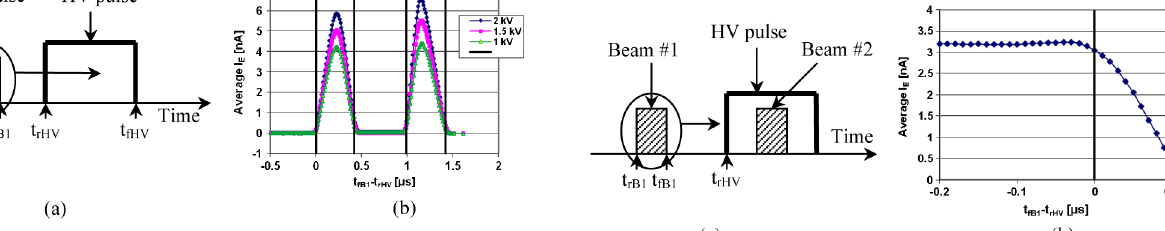
FIG. 6. (a) Pulsing diagram of the test, T B1 ¼ T B2 ¼ 0 : 1 (cid:1) s , ¼ 1 (cid:1) s , V ¼ 2 kV ; beam #2 was embedded in the HV T HV HV pulse and beam #1 approached the HV pulse in steps of 10 ns. (b) Average I E at each step. Vertical line: t fB1 ¼ t rHV . Peak emission gain was